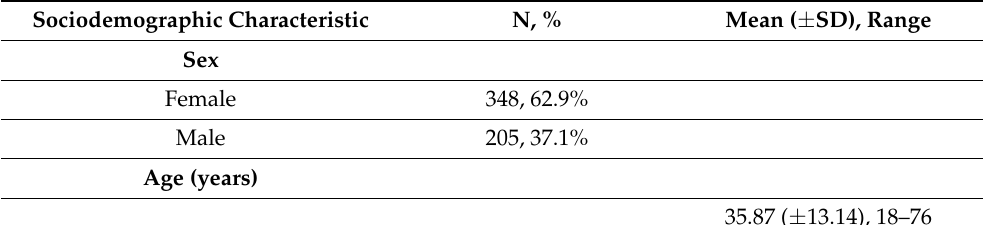
Table 1. Descriptive Statistics for the basic sociodemographic data of the study participants ( n = 553). Sociodemographic